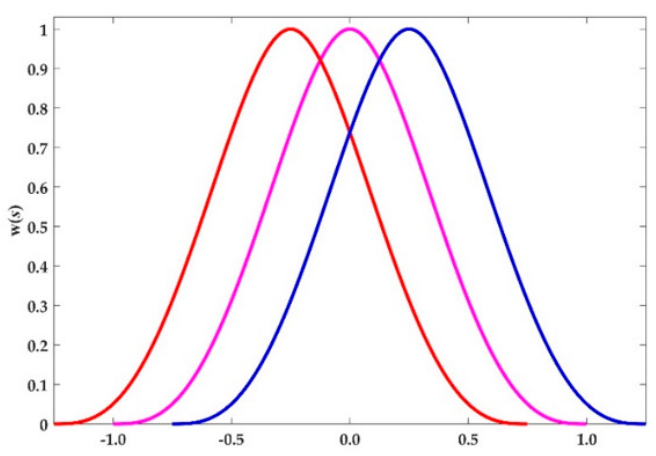
Figure 1. The compact support of weight function.